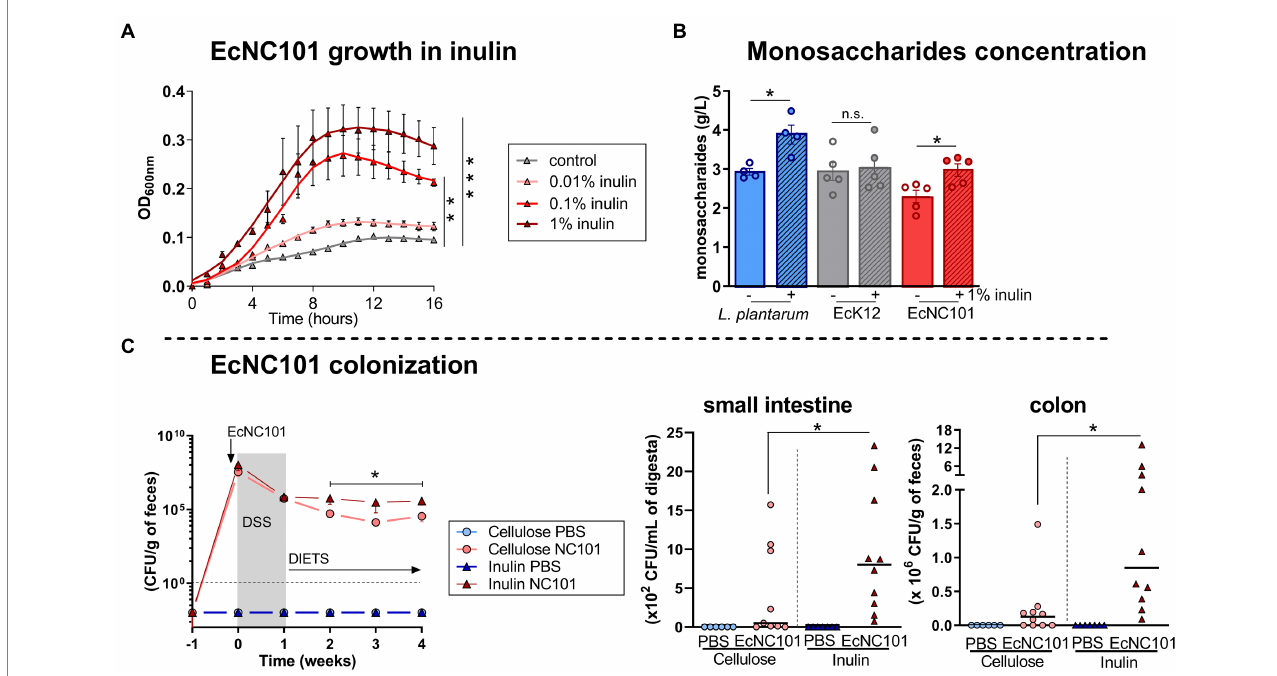
FIGURE 3 Inulin effect on EcNC101 growth and colonization. (A) Growth curves (repeated-ANOVA, compared to control). (B) Monosaccharide concentration in the medium inoculated with inulin-fermenting L. plantarum (positive control), EcK12 (negative control), and EcNC101 (Student’s t -test); (C) Fecal homogenates were cultured on MacConkey agar for Enterobacteriaceae detection at W 0, 1, 2, 3 and 4. Quantification of EcNC101 colonization by CFUs in the small intestine and colon. n.s. non-significant, * p < 0.05, ** p < 0.01, *** p < 0.001.